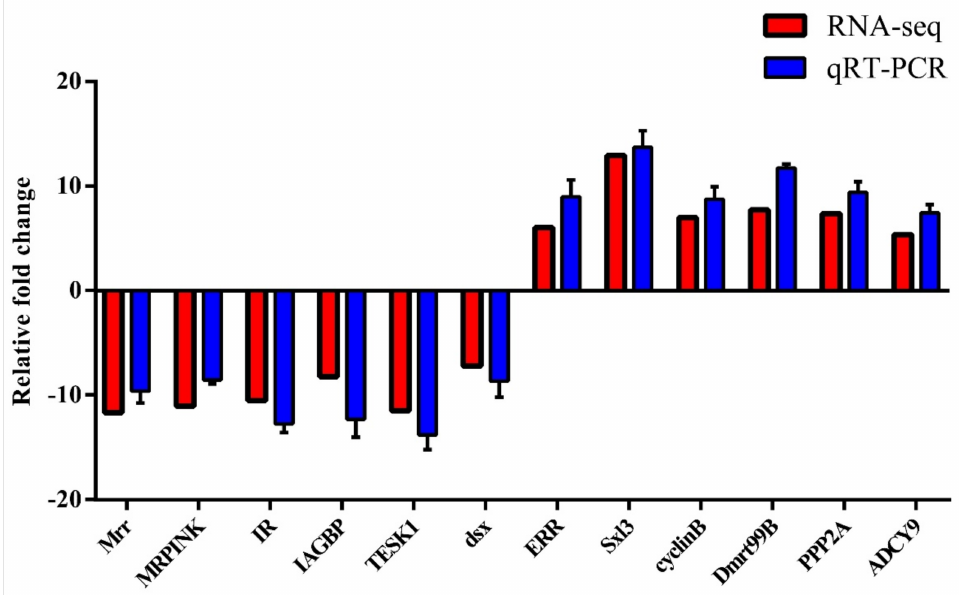
Figure 5. The qRT-PCR validation of DEGs was analyzed compared with RNA-seq data; the qRT-PCR analysis of 12 selected DEGs: The x -axis is the 12 DEGs, and the y -axis shows the relative mRNA expression levels are based on qRT-PCR, and the log 2 FC is based on DGEs’ analysis. The values are shown as the means ±